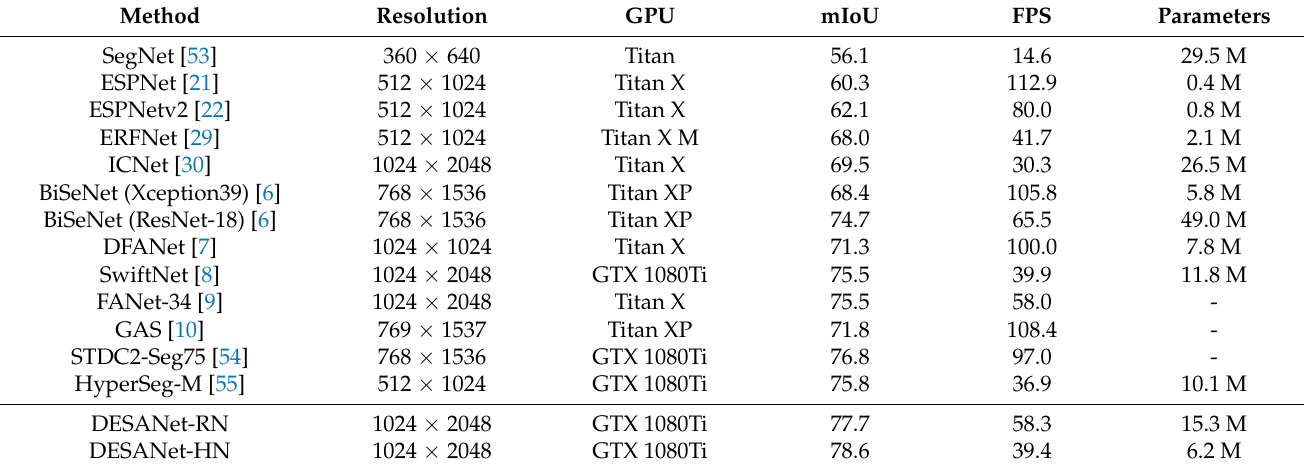
Table 1. Quantitative results in the test data of the Cityscapes